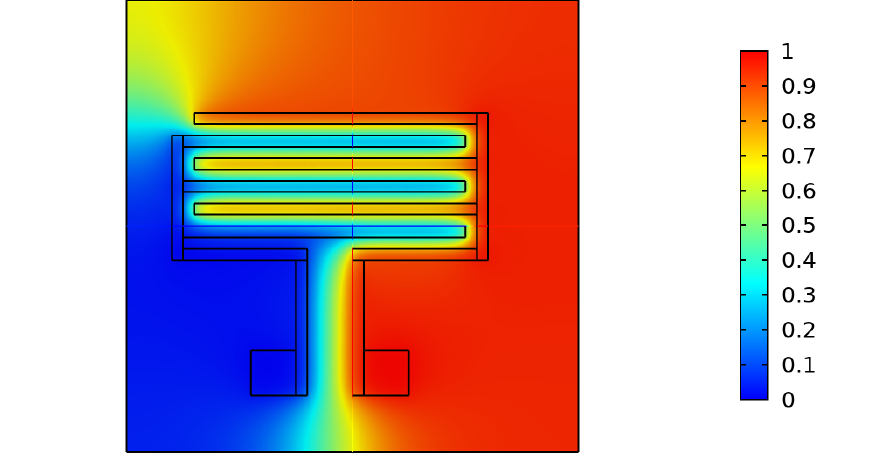
Figure 2. Electric distribution (V) in 3D mode for the rectangular IDE.